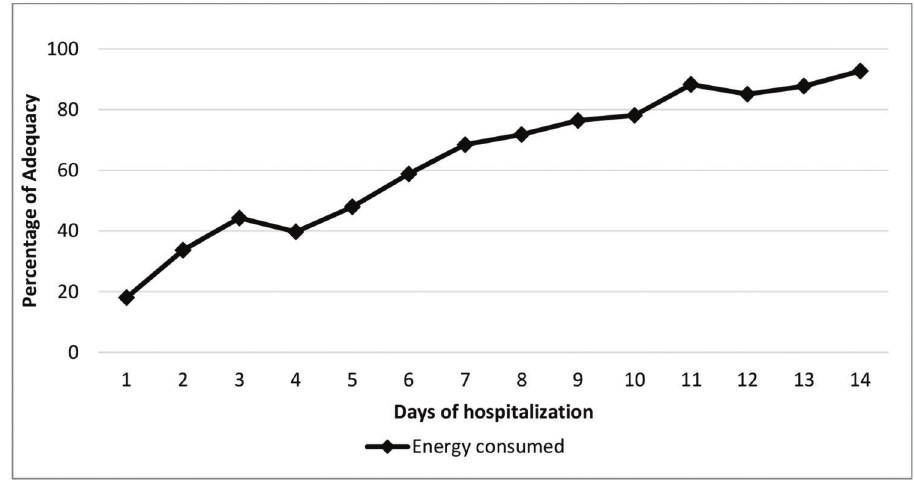
Figure 3 - Percentage of adequate consumption of the estimated energy requirements by microcephalic newborns during hospi- talization at IFF/FIOCRUZ, Rio de Janeiro, Brazil, 2016. Percentage with adequate consumption; Days of hospitalization; Energy